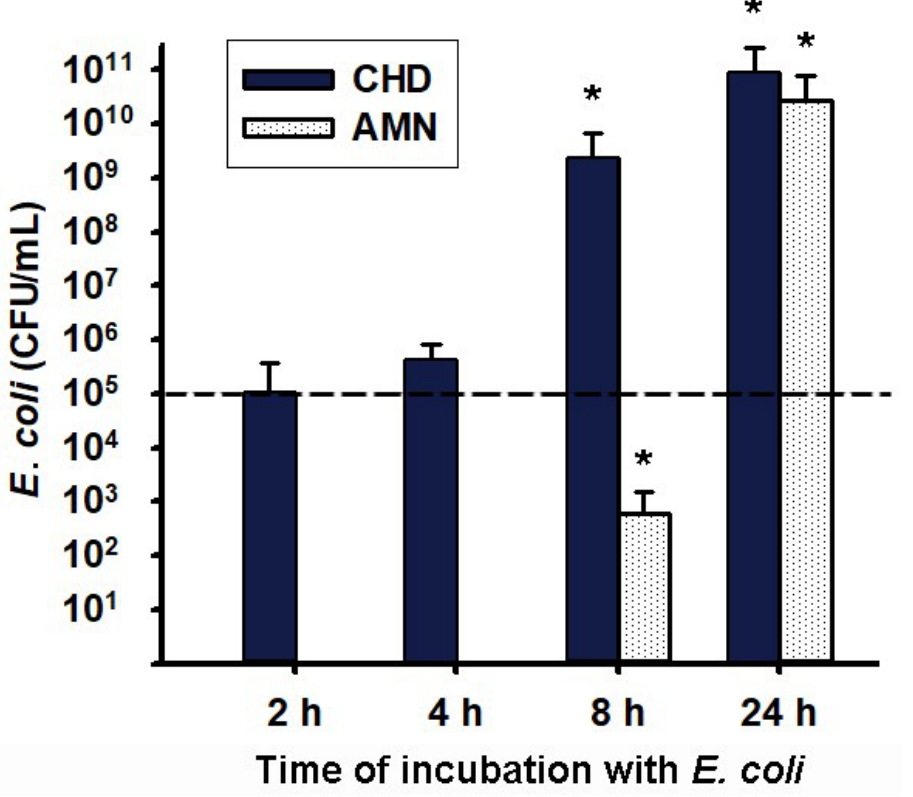
Figure 3. Transmembrane migration of Escherichia coli from choriodecidual to amnion culture media. An inoculum of 1 × 10 5 CFU/mL E. coli was used to infect the CHD compartment (shown as a dashed line). The tissue culture proceeded for 24 h, and an aliquot of the media was used to assess the CFU/mL at each follow-up time point (2, 4, 8, and 24 h). The data are presented as means ± SD. n = 6–7 independent experiments in triplicate. In the case of the CHD (dark bars), * p < 0.05 vs. the initial load of bacteria, represented by the dashed line. In the case of the AMN (white bars), * p < 0.05 vs. 2 h and 4 h, which were time points with undetectable bacteria, given that the inoculum was placed in the CHD compartment. As depicted, the bacteria migrated towards the AMN and were significantly detected at 8 h and 24 h. AMN: Amnion. CHD: Choriodecidua.